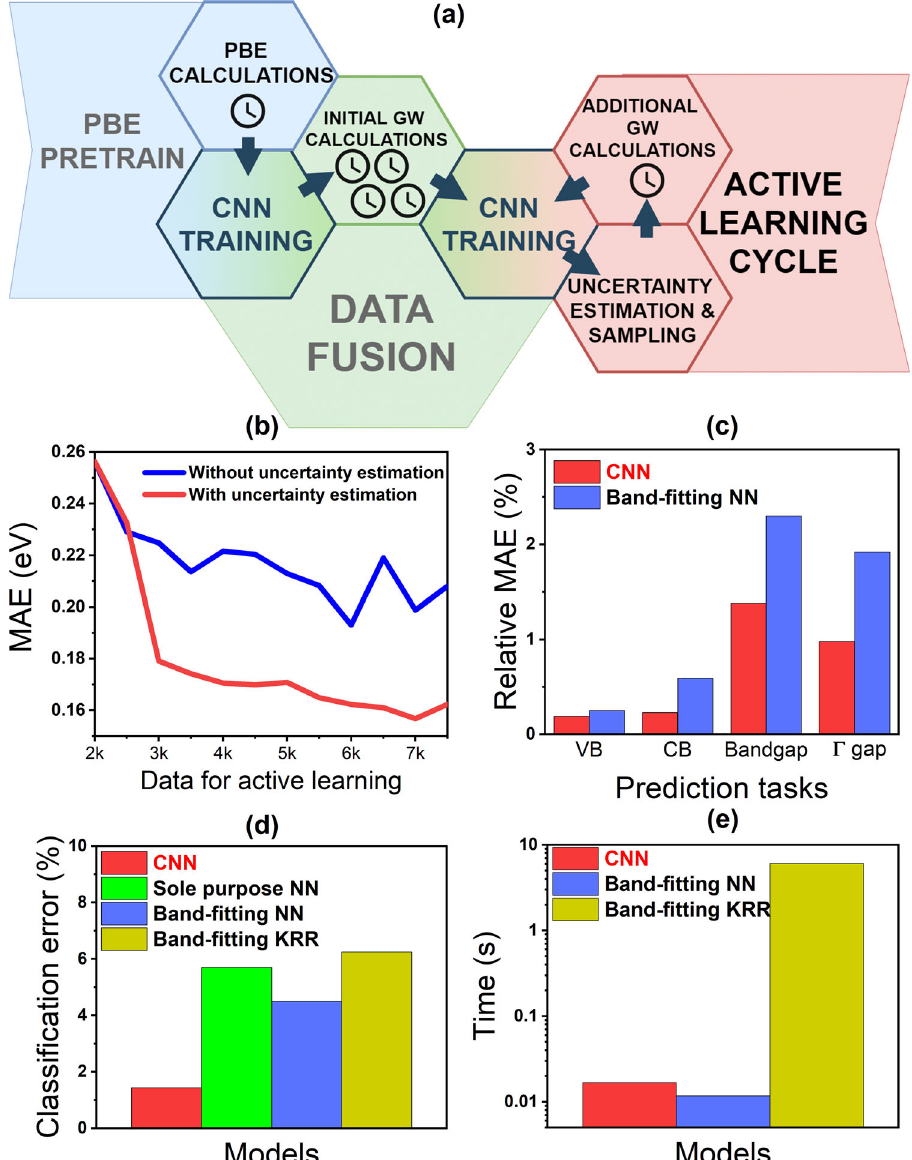
Fig. 3 ML accuracy and comparison of the different ML models. a The entire ML scheme involves pre-train, data fusion, and active learning. The solid arrows show the work fl ow, and clock symbols indicate the relative time required for ab initio calculations. b Steady improvement of model performance in terms of mean absolute error (MAE) during active learning with and without uncertainty estimation on PBE data. c Physics-informed CNN holds signi fi cant advantages over band- fi tting NN while being able to accomplish prediction tasks, which the feed- forward NN and KRR do not offer. “ Γ gap ” is the difference between the conduction band (CB) and valence band (VB) at Γ and it usually does not coincide with E g . d Accuracy of CNN and other models for CBM position classi fi cation task. e Inference time comparison. The CNN is much faster than its closest accuracy competitor band- fi tting KRR model, providing a reasonable balance between time and accuracy